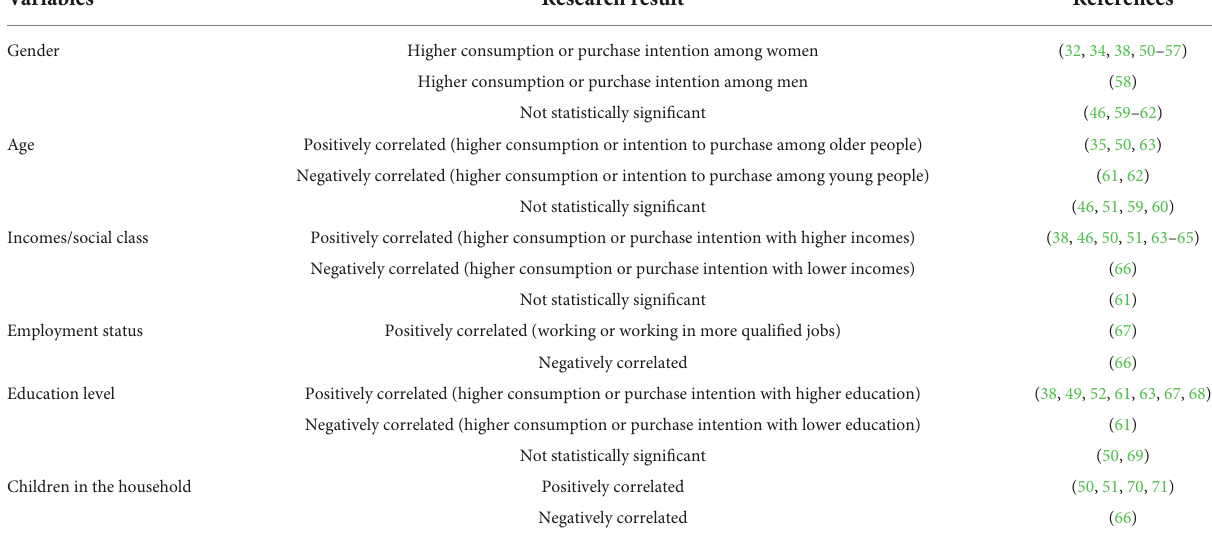
TABLE 3 Impact of socio-demographic factors on the purchase/purchase intention of organic foods.